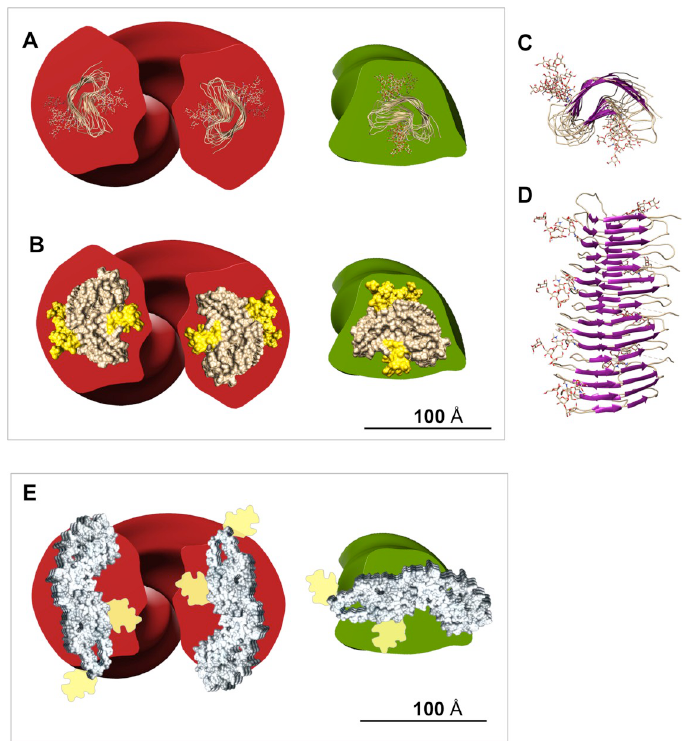
Fig 10. Superimposition of the 3D L-type BSE fibril reconstructions with the proposed structures for PrP Sc . ( A ) A representative view of the 4R β S model of PrP Sc with attached N-linked glycans superimposed onto the cross-section view of 3D reconstructions of a two-protofilament (red) and a one-protofilament (green) L-type BSE fibril. The size of the 4R β S model (50 Å x 30 Å ) was set based on the previous cryo-EM and molecular dynamics simulation studies [24,25].( B ) A surface view of the 4R β S PrP Sc model carrying glycans superimposed onto the cross-section view of 3D reconstructions of a two-protofilament (red) and a one-protofilament (green) L-type BSE fibril. ( C ) Top and ( D ) side views of a representative tetrameric version of the 4R β S PrP Sc model containing glycans [25]. ( E ) Superimposition of the cross-section of a two-protofilament (red) and a one-protofilament (green) L-type BSE fibril and the PIRIBS structure obtained from the recent cryo-EM study on brain-derived 263K prions [28]. The size of the PIRIBS structure (13 nm) was set as indicated in the pre-print. The space-filling view shows the protein moiety only. Estimated densities representing N-linked glycans are attached to the structure in positions indicated in the pre-print [28].